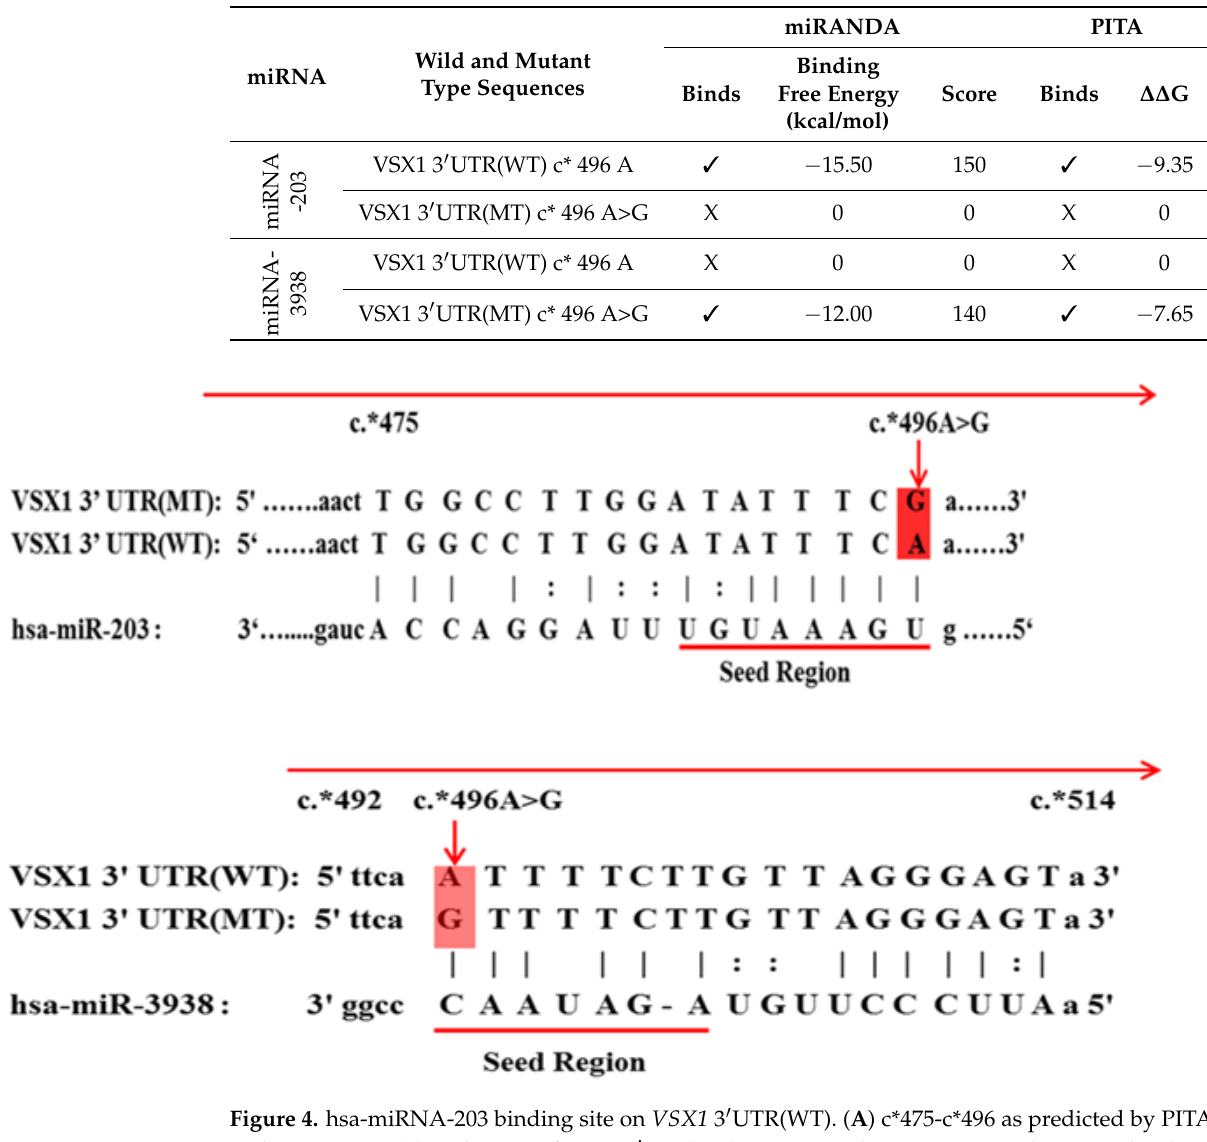
Table 4. Variations in binding properties of miRNA-203 and miRNA-3938 with VSX1 3 (cid:48) UTR (WT) as predicted by miRANDA and PITA.